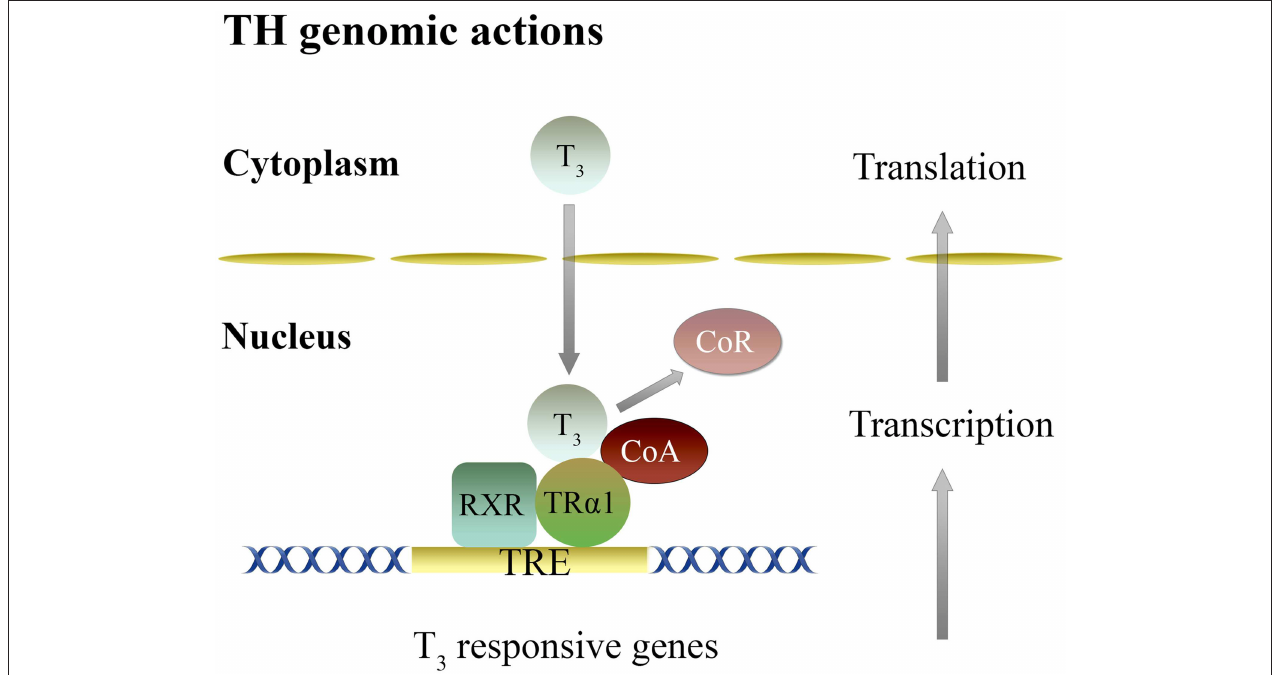
FIGURE 1 | Genomic mechanisms of thyroid hormones action in the brain. Genomic actions of T 3 are dependent on gene transcription mediated by its binding to nuclear TR α and TR β , and the formation of heterodimer complex with RXR (RXR-TR) that binds to a TRE, located at the regulatory region of T 3 target genes. This activity is regulated by an exchange of CoR for CoA. CoA, Co-activator; CoR, Co-repressor; RXR, Retinoid X receptor; TR, Thyroid hormone receptor; TRE, Thyroid response element; T 3 , 3,5,3 ′